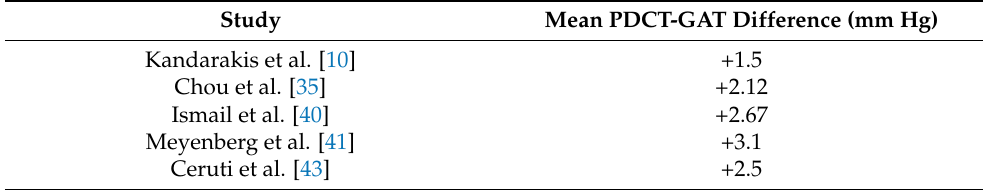
Table 2. Mean difference between PDCT and GAT measurements in post-PK eyes. Study Mean PDCT-GAT Difference (mm Hg) Kandarakis et al. [10] +1.5 Chou et al. [35] +2.12 Ismail et al. [40] +2.67 Meyenberg et al. [41] +3.1 Ceruti et al. [43]